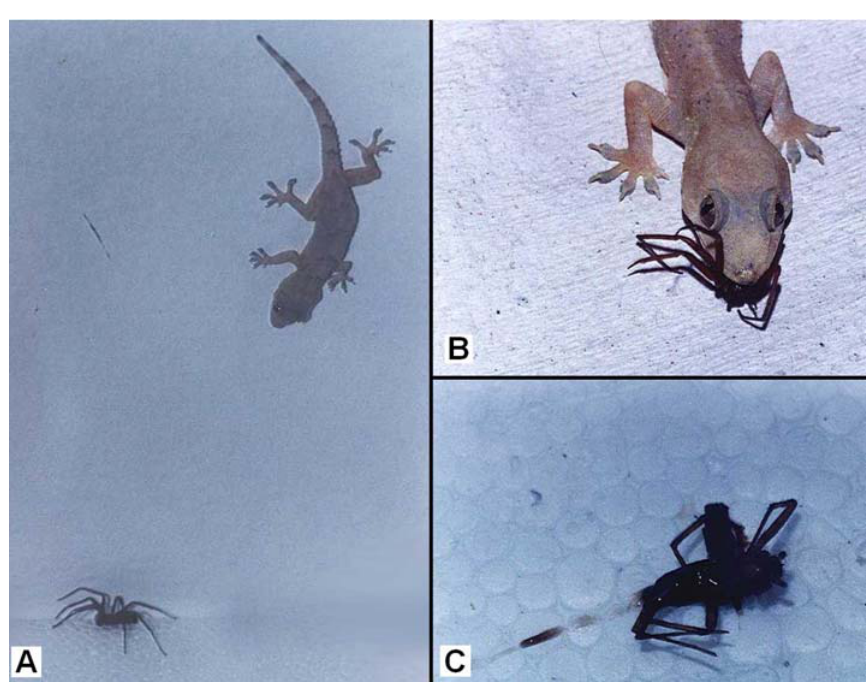
Figure 1 . (A): H. mabouia approaching a female L. intermedia spider. (B): H. mabouia ingesting a female L. intermedia . (C): L. intermedia female released by H. mabouia after disturbance. The spider autotomized two legs and had its abdomen